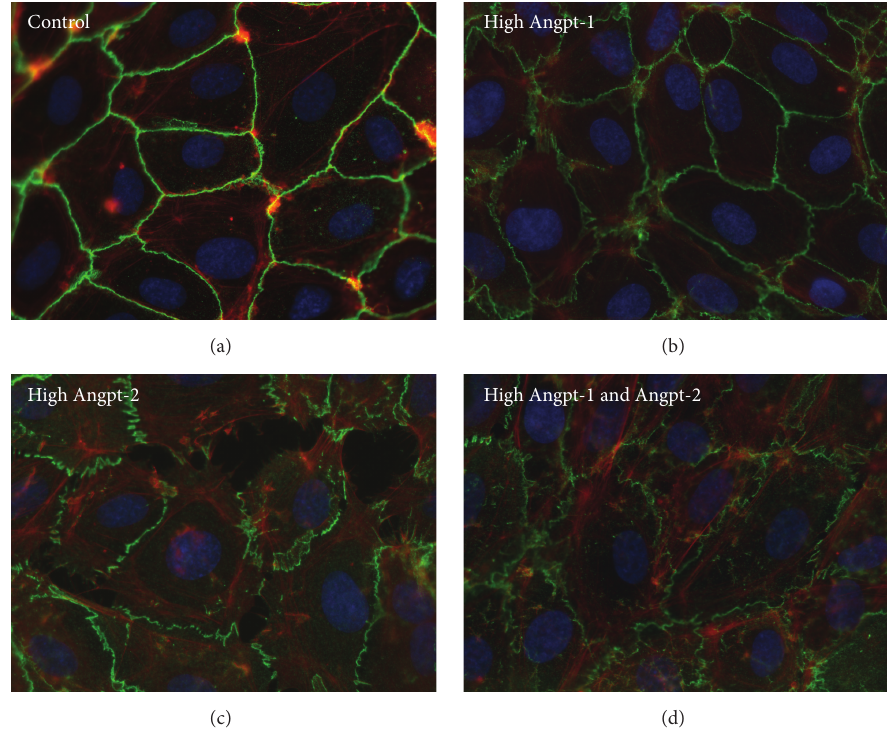
Figure 2: Fluorescent immunocytochemistry microscopy images showing immunofluorescence staining for F-actin (red) and VE-cadherin (green) performed on 100% confluent P5 HMVECs. Cells were treated with 5% prefiltered human EDTA plasma. EDTA plasma samples were collected from healthy controls (a), patients with high Angpt-1 (Angpt-1: 15.5 and 17.2ng/mL) (b), high Angpt-2 (Angpt-2: 13.6 and 15.6 ng/mL) (c), and both high Angpt-1 and Angpt-2 (Angpt-1: 12.1 and 10.1ng/mL, Angpt-2: 9.3 and 12.9 ng/mL, resp.)